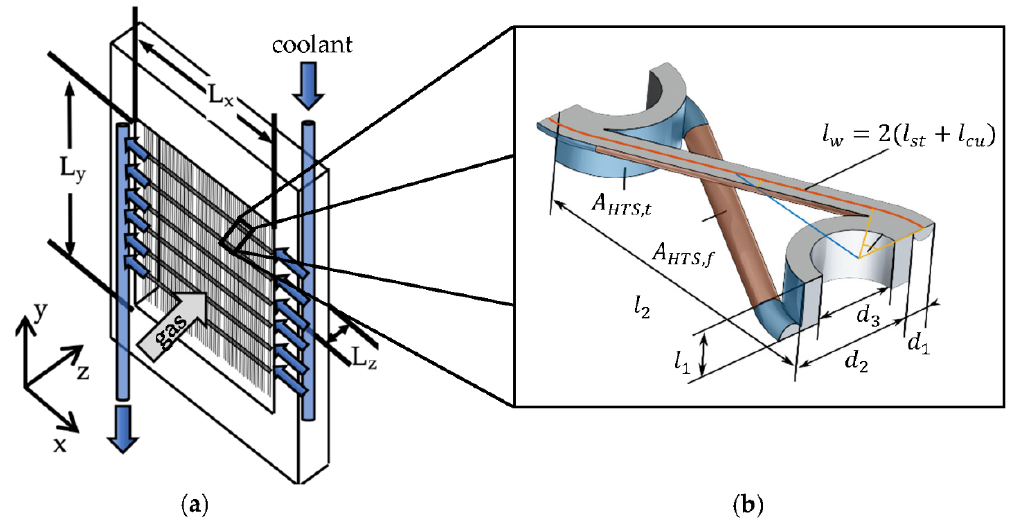
Figure 2. ( a ) Schematic view of the entire woven wire heat exchanger with common manifold inlet and outlet for the coolant tubes colored in blue. The relevant length dimensions are shown with the axes of the heat exchanger tubes pointing in the x-direction. ( b ) Characteristic symmetric / periodic (in the x- and y-directions) section of the woven heat exchanger with relevant geometric variables. The gas-side heat transfer surface area can be separated in the tube and connected wire A HTS , t and fin A HTS , f .